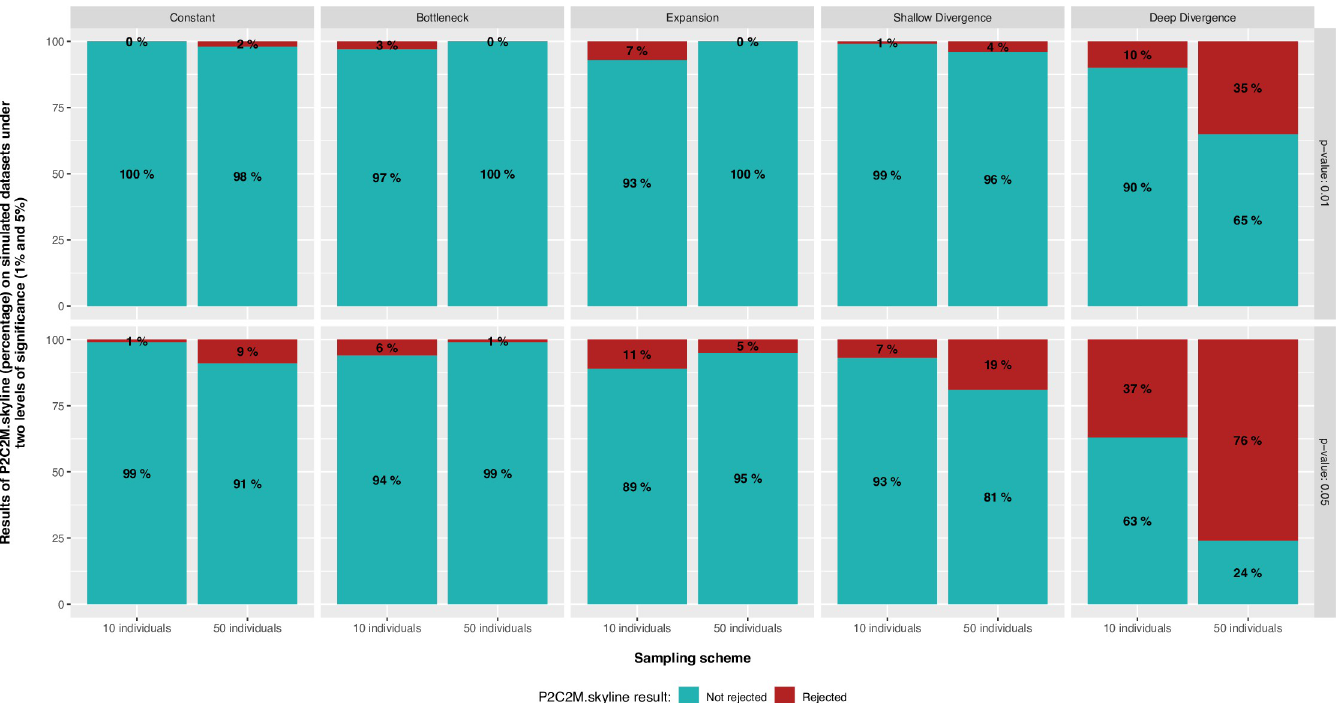
Fig 2. Percentage of simulated datasets with a p-value of < 1% and 5% across the five different diversification scenarios. In each chart, the Y-axis shows the percentage of replicates where the statistical fit of the Bayesian Skyline model is rejected or not under two sampling schemes (10 and 50 individuals).